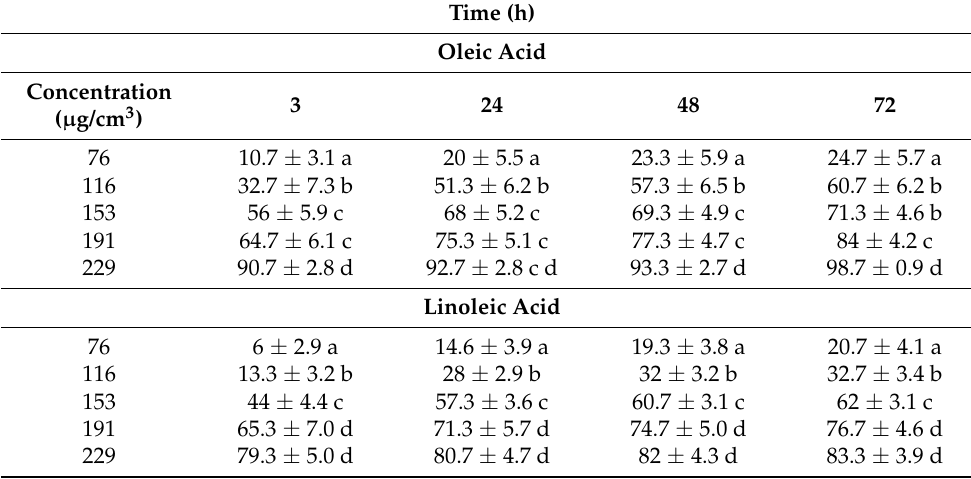
Table 6. Larvicidal activity (%) of oleic acid and linoleic acid to L. botrana recorded at 3, 24, 48, and 72 h after Petri dish residual exposure bioassay. Means followed by the same letter within each column are not significantly different (Duncan’s multiple range tests [MRT] test p > 0.005). Time (h) Oleic Acid Concentration